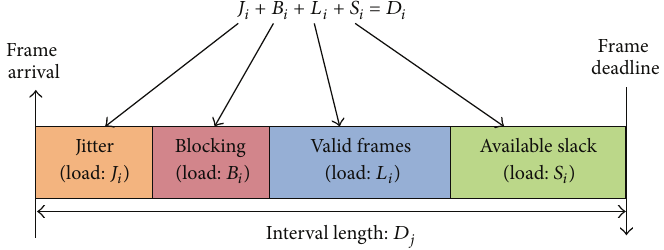
Figure 2: Illustration of the proposed slack analysis